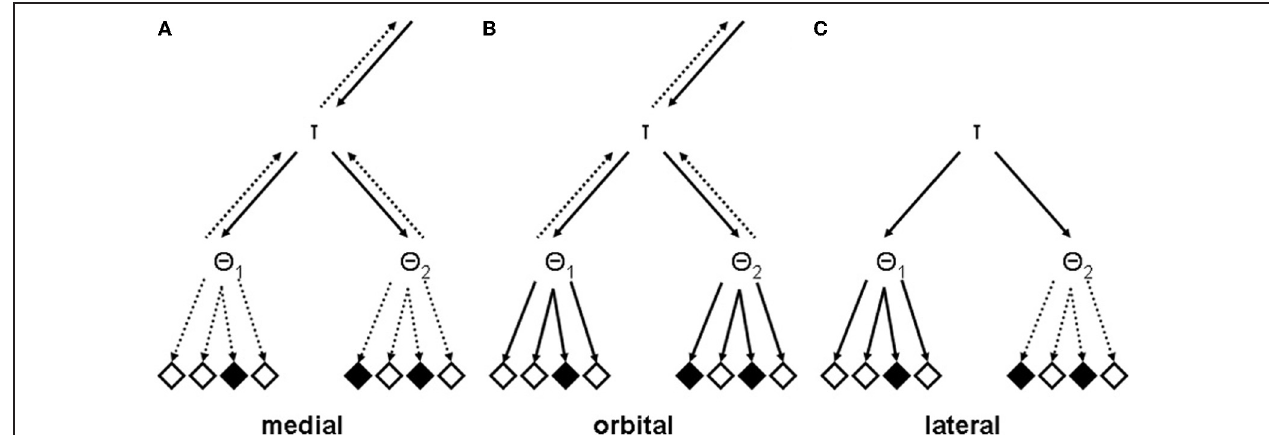
FIGURE 3 | Analytically lesioned recursive mental TOTE models. (A) A potential lesion that might underlie the medial syndrome with predominantly apathetic symptoms. Note that the connections between both units at the lowest level of the hierarchical structure, θ 1 and θ 2 , and executable behavioral units are inactive (dashed arrows). (B) A potential lesion that might underlie the orbital syndrome with predominantly disorganized symptoms. Note that the connections between both units at the lowest level of the hierarchical structure, θ 1 and θ 2 , and executable behavioral units are active (solid arrows). (C) Potential lesions that